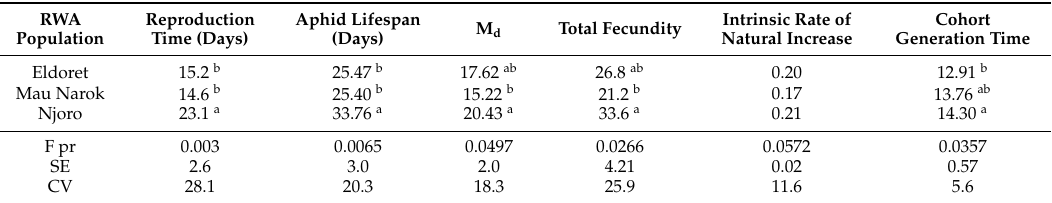
Table 6. The differences in reproduction time, total aphid lifespan, effective fecundity (M d ) and total fecundity of RWA